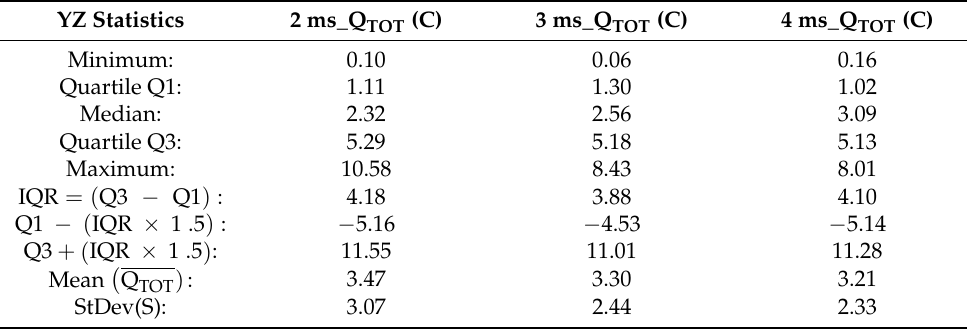
Table 4. YZ five-number summary and outlier